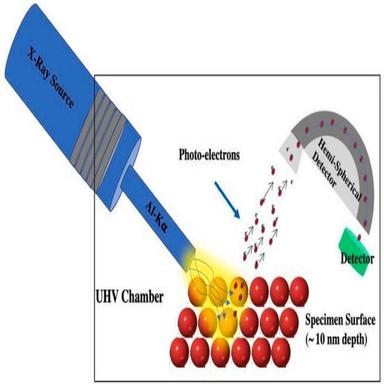
The schematic of X-ray Photoelectron Spectroscopy.